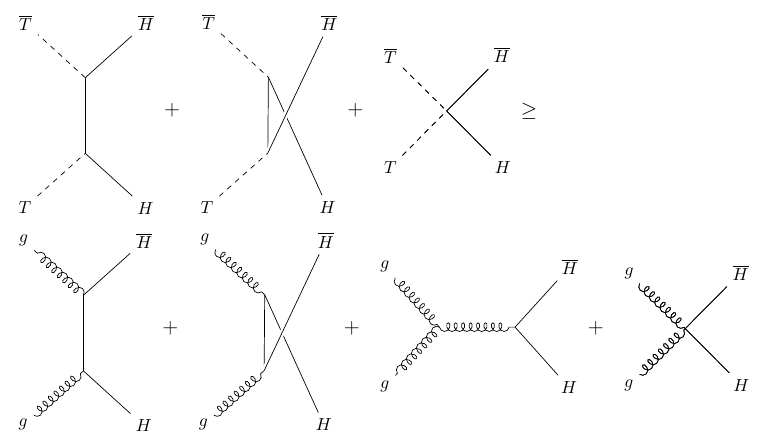
Figure 4 . Tree level diagrams contributing to the pair production in the scalar theory and linearized Einstein gravity. We assign the letter N to the diagrams with